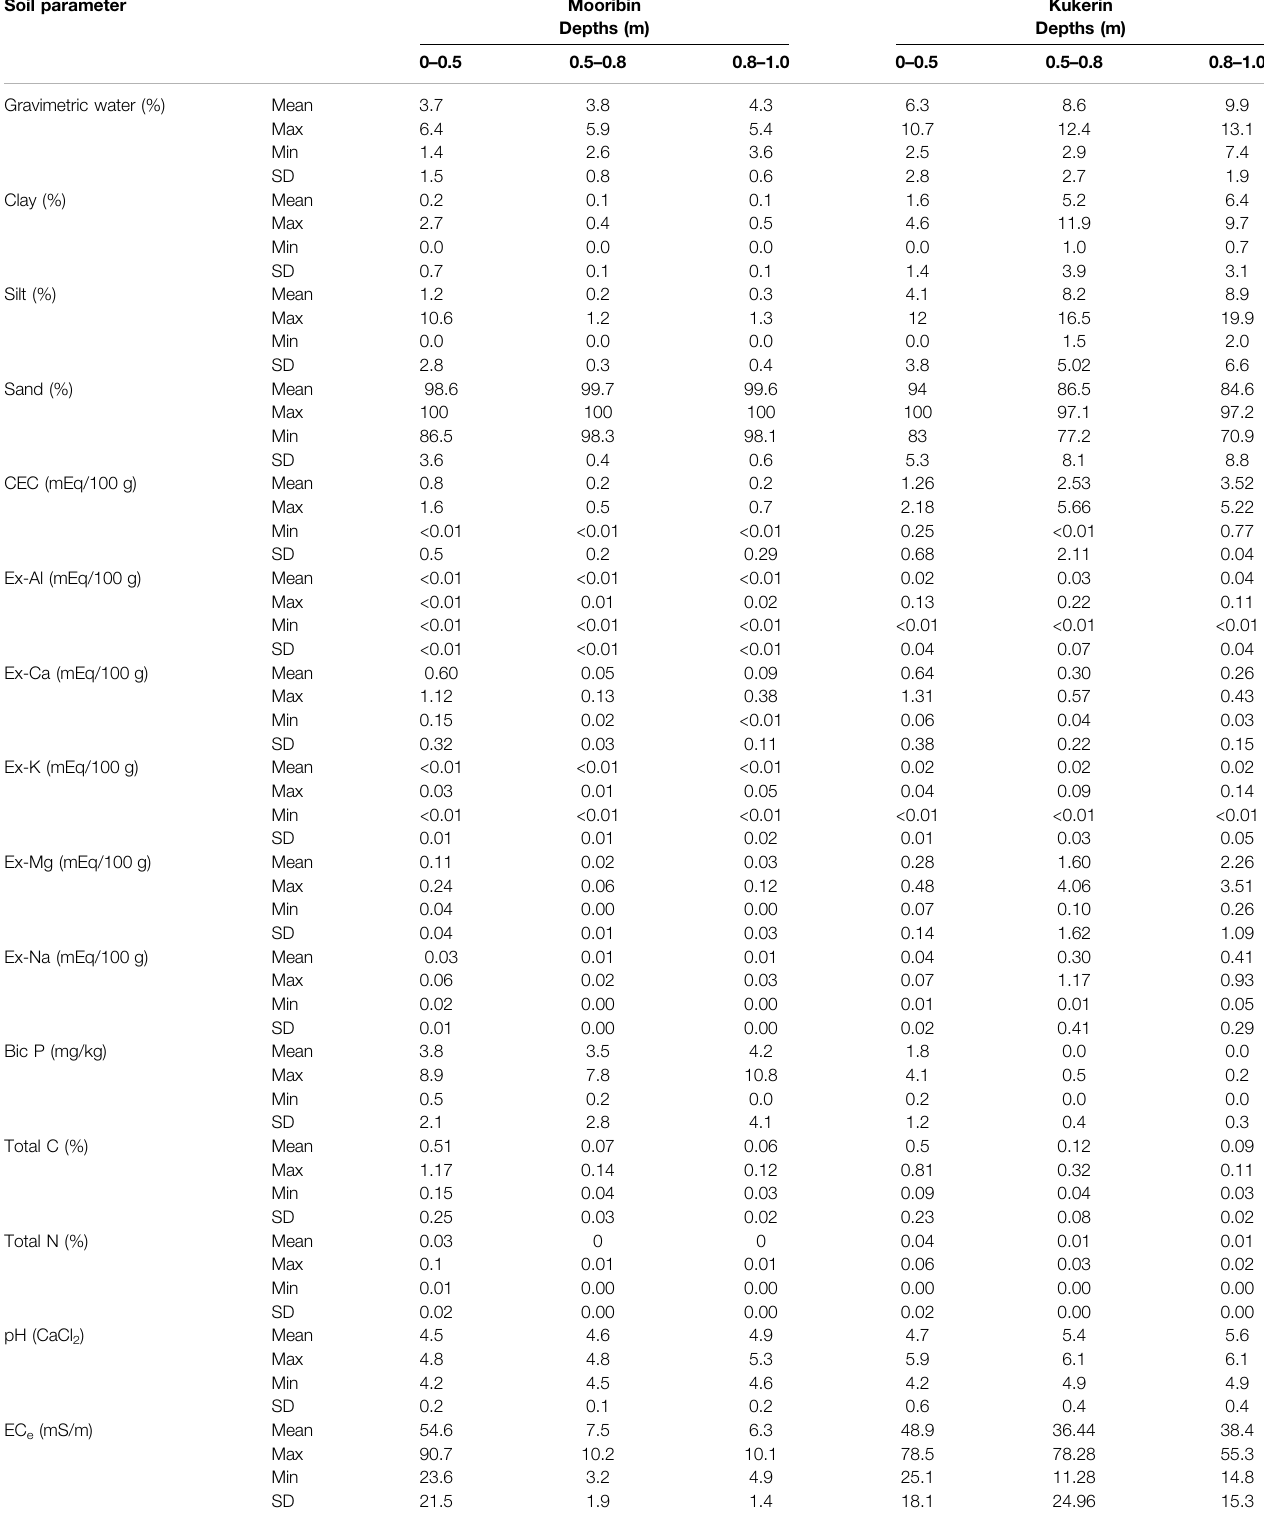
TABLE 2 | Summary results of soil analysis for the two study sites. Soil parameter